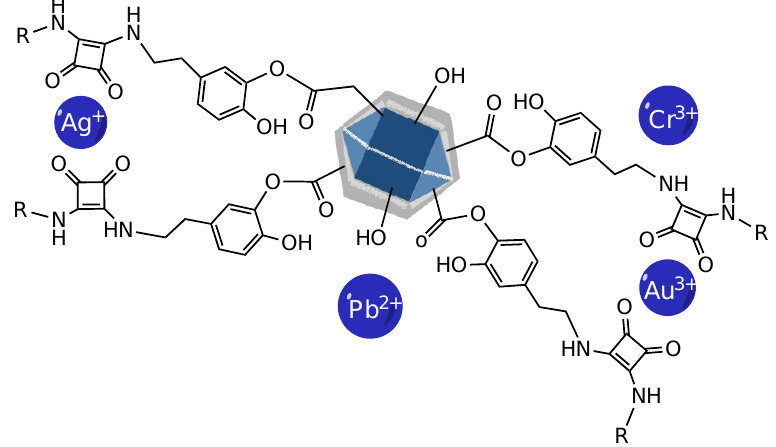
Figure 9. Proposal of the interaction between ND-SQ1 and the Au 3+ and Ag + ions.